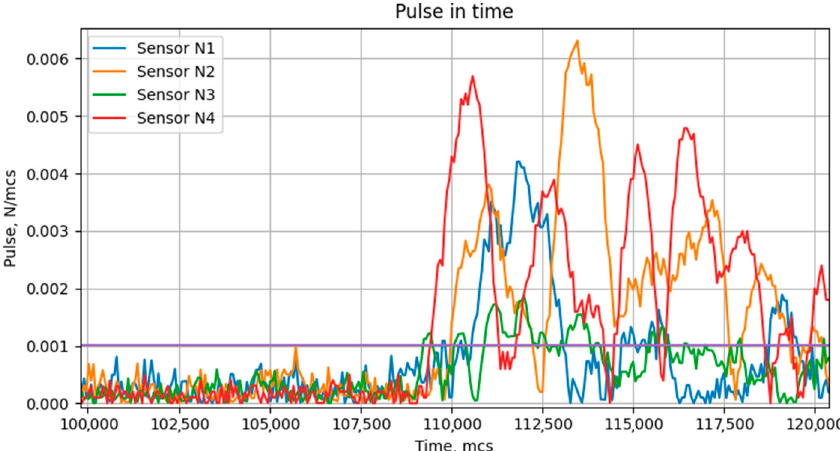
Figure 13. Increase in the signal value derivative for each of four strain gauge sensors (detailed